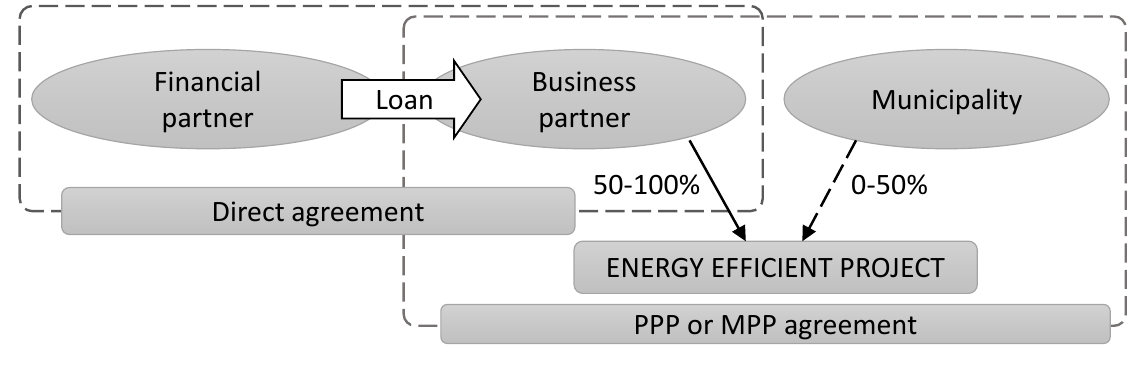
Figure 1. Organizational and financial schemes for financing energy efficiency projects through PPP and MPP